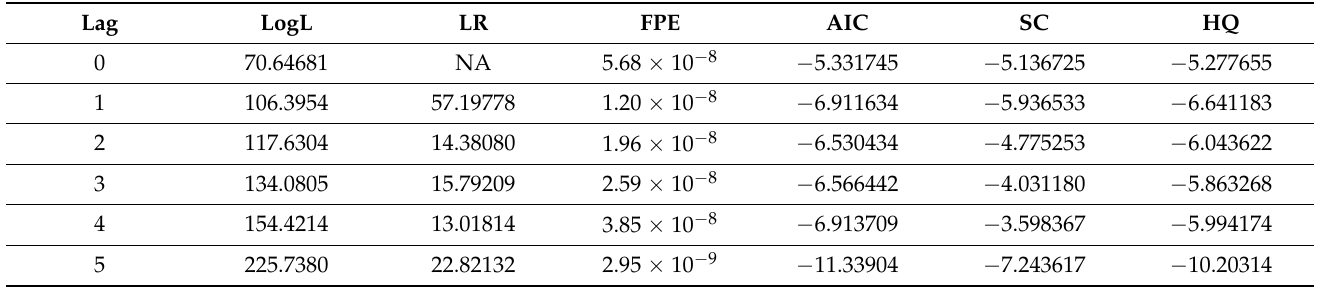
Table 5. Results of Granger Causality for the Returns of Crude Oil Price Shocks on GDP per Capita, and Exchange Rate in India during the period from 1990 to 2020.